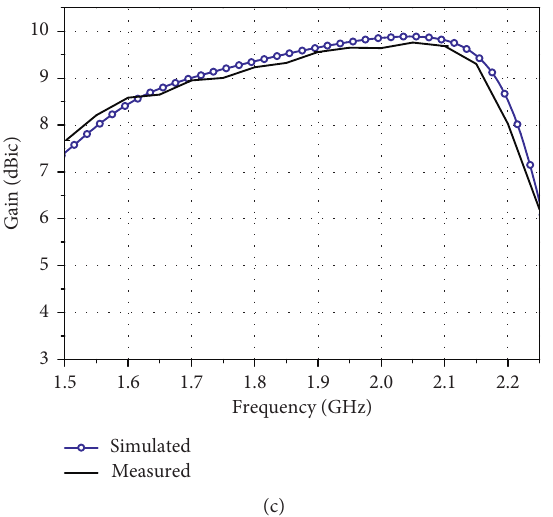
Figure 17: Measured and simulated results: (a) S